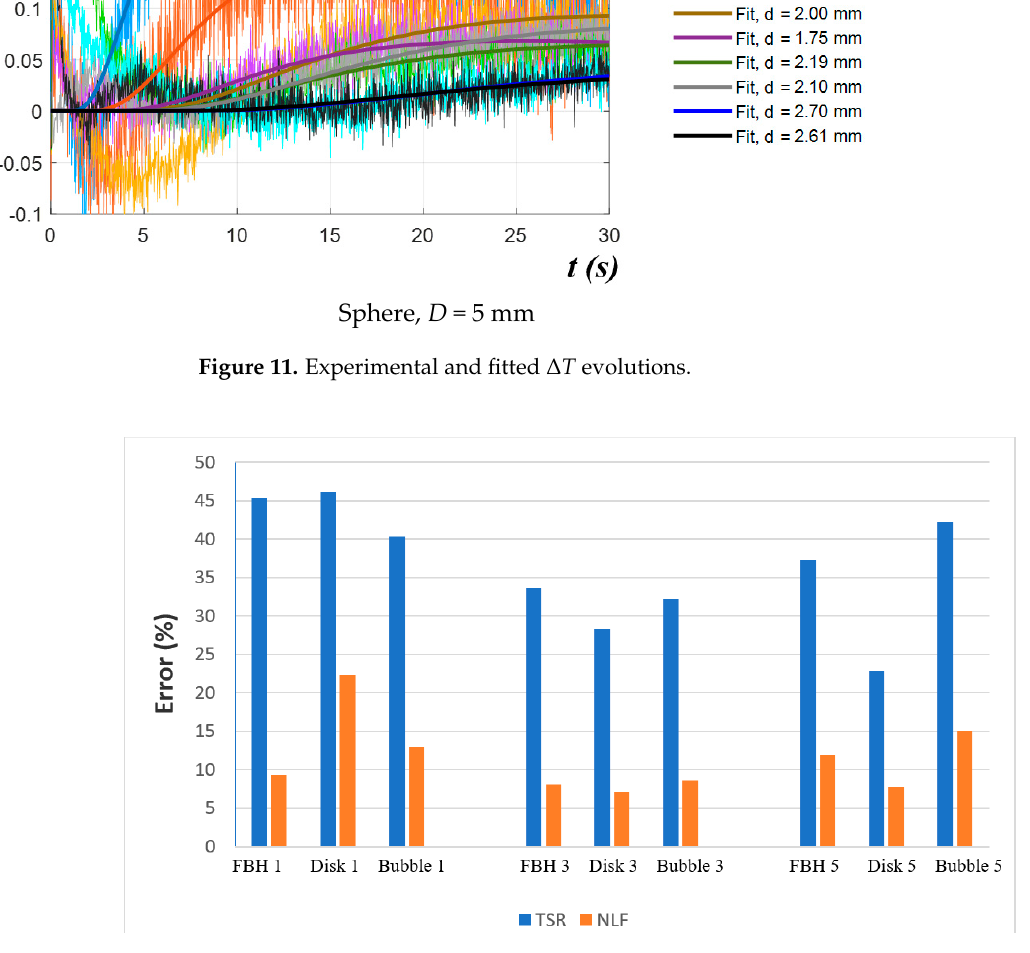
Figure 12. Mean relative errors of depth estimation by using TSR and NLF techniques (experiment).